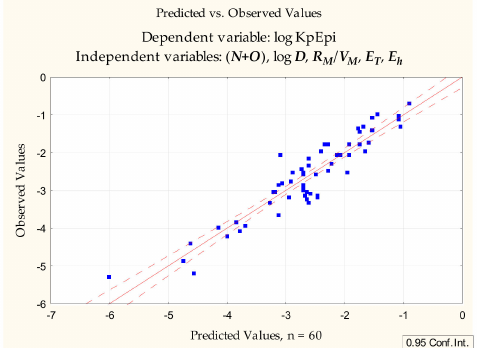
Figure 4. Equation (8)—predicted vs. observed